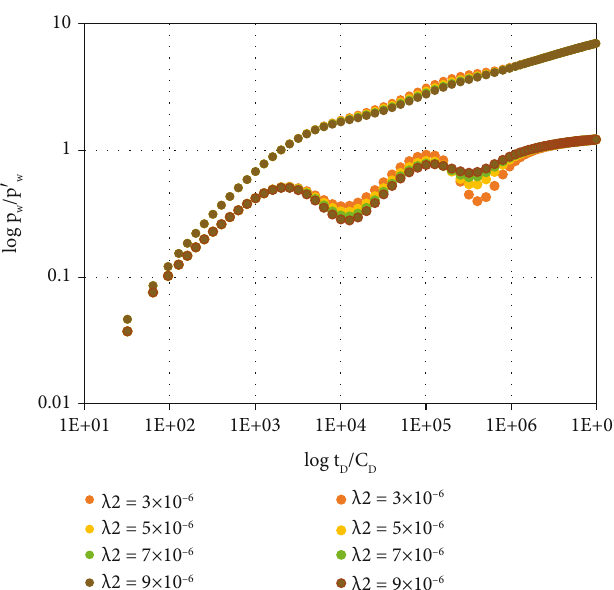
Figure 10: In fl uence curve of channeling coe ffi cient of the outer zone on pressure di ff erence and pressure di ff erence derivative